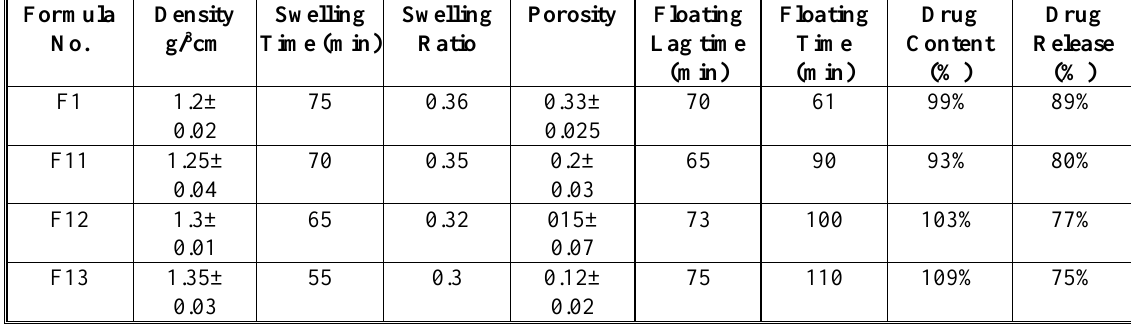
Table 6. Effect of PVA Amount on SPH Properties.